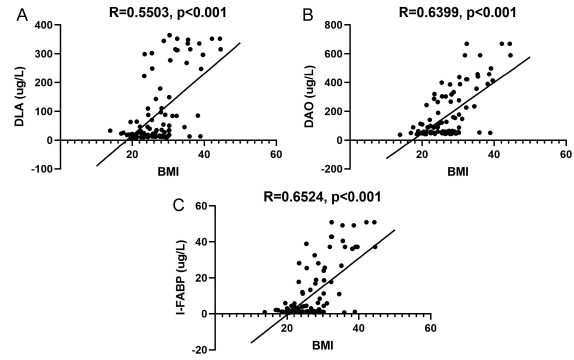
Figure 4. Correlation between BMI and intestinal barrier permeability. (A) Correlation between BMI and DLA; (B) correlation between BMI and DAO; (C) correlation between BMI and I-FABP. There was a moderate correlation between BMI and the serum levels of DLA, DAO, and I-FABP. BMI, body mass index; DLA, d -lactate; DAO, diamine oxidase; I-FABP, intestinal fatty acid binding proteins.